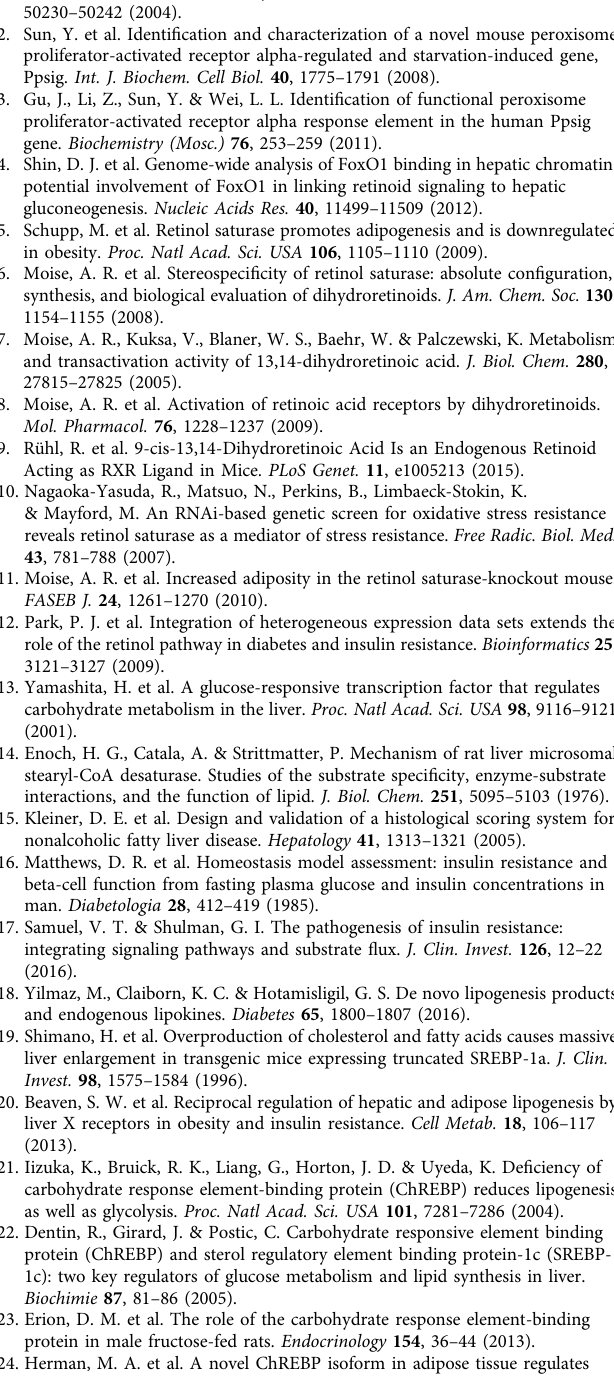
Supplementary Table 3. Gene expression pro fi ling was performed using Affymetrix Mouse Gene 1.0 ST Array arrays by hybridizing three independent transfections of control or RetSat siRNA-treated primary hepatocytes as described previously 5 by the University of Pennsylvania Microarray Core Facility. Gene Ontology analysis